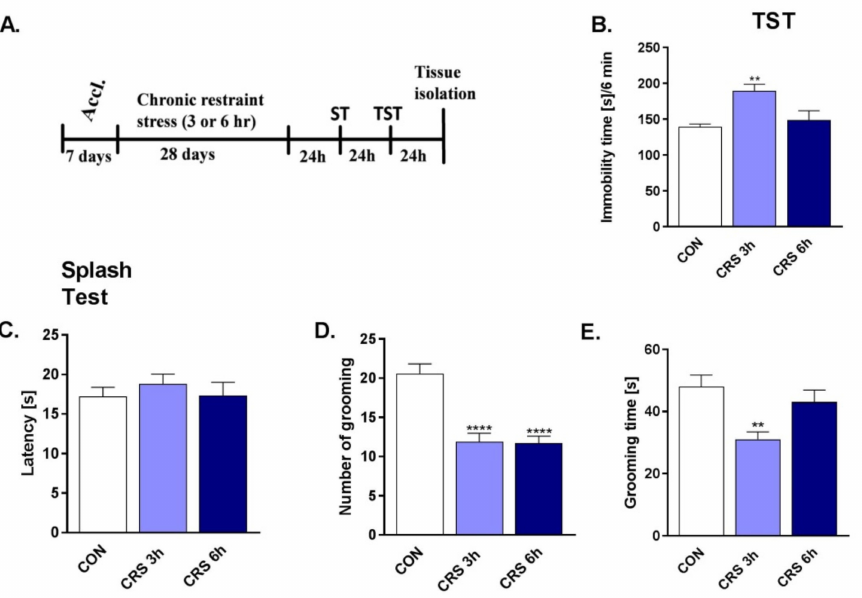
Figure 1. The effect of 3 and 6 h of immobility/day/28 days on the behavior of mice. ( A ) Experimental schedule; ( B ) Effects of CRS in the TST; ( C – E ) Effects of CRS in the ST in mice. Data were analyzed using one-way analysis of variance (ANOVA) and Dunnett’s multiple comparison test. Values are expressed as mean ± SEM. n = 19–22., ** p < 0.01, **** p < 0.0001 vs. CON. CON–control